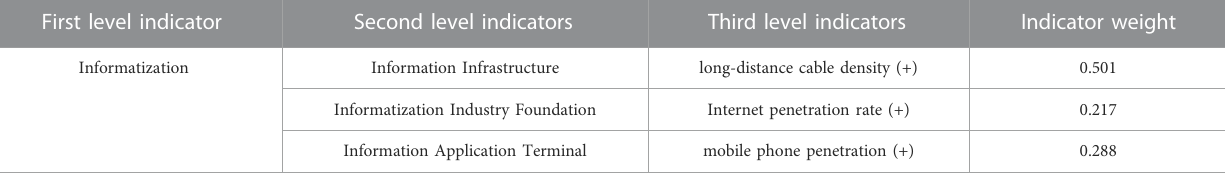
TABLE 3 Index evaluation system and weight for informatization.